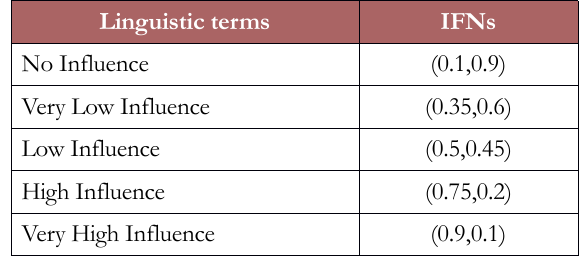
Table 4. Intuitionistic fuzzy linguistic